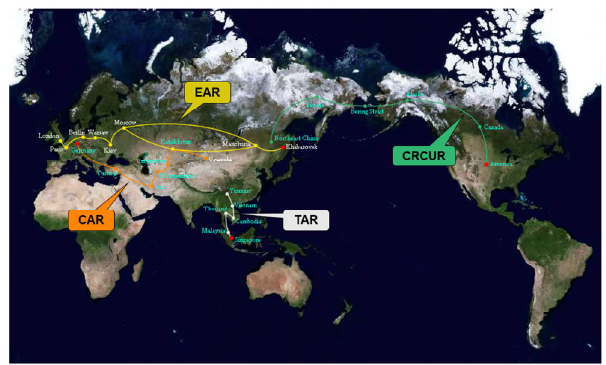
Fig. 12 Potential future railway lines under